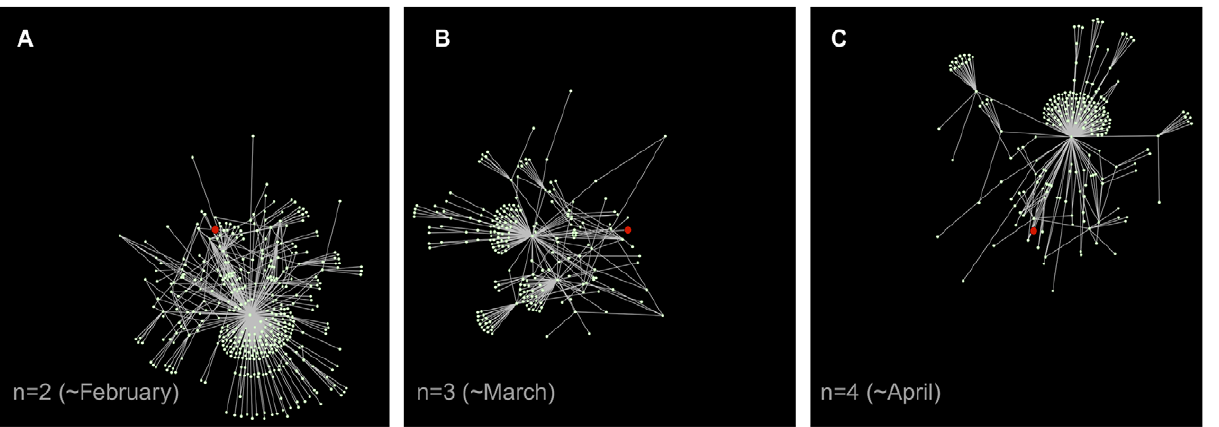
Figure 5. Neighborhoods of a selected node in three consecutive monthly networks. The subgraphs are obtained by showing all nodes within distance 3 from a selected node (in red in the figure), for consecutive monthly snapshots. The visualization highlights how the neighborhood of a given node may strongly change its structure in time. It is important to note that nodes that disappear from the plots may still be present in the network, but are not shown as they may be at distance larger than 3 from the seed, thus not belonging to its